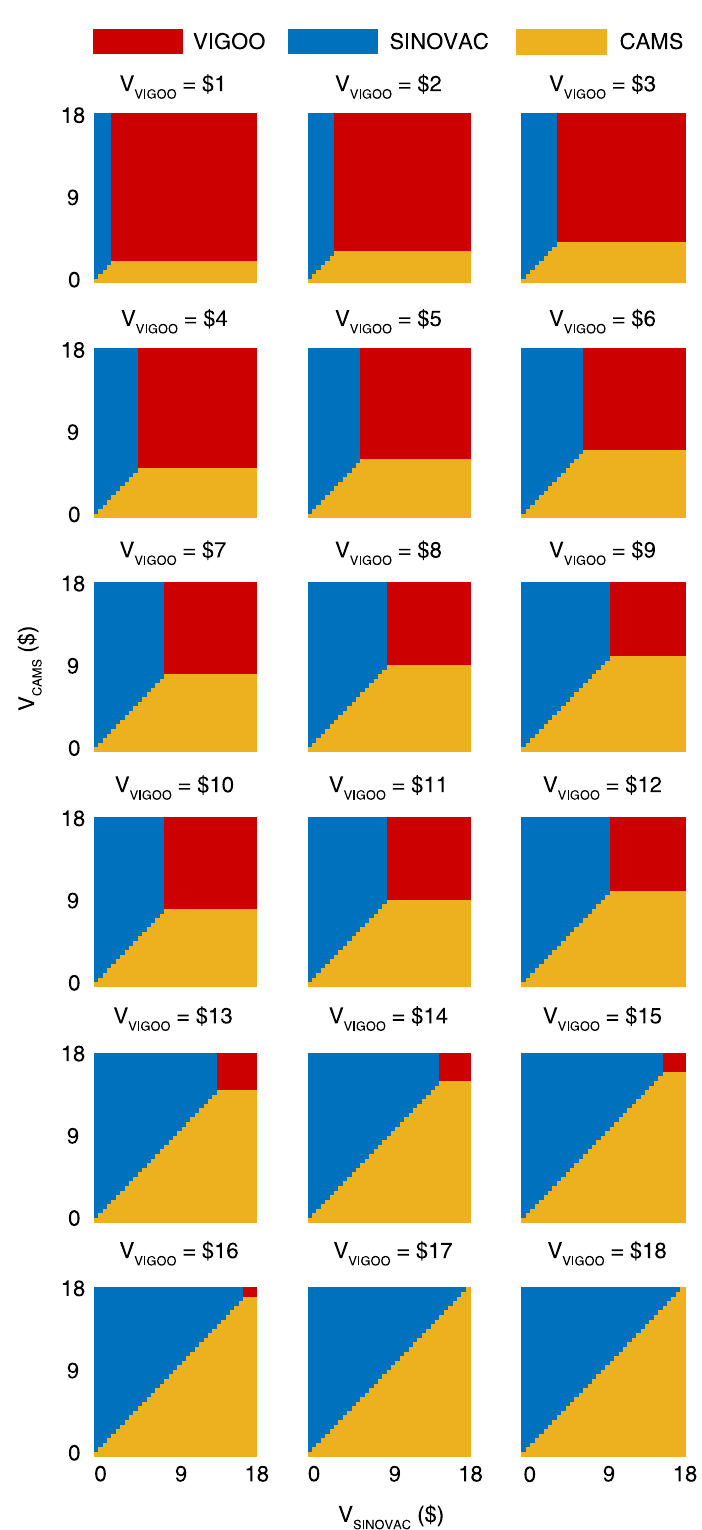
Fig 5. Comparative cost-effectiveness analysis of the three vaccine candidates based on the base- case EVC max . The color coding indicates the optimal vaccine given the costs of the three vaccines ( V Vigoo , V V Sinovac , CAMS